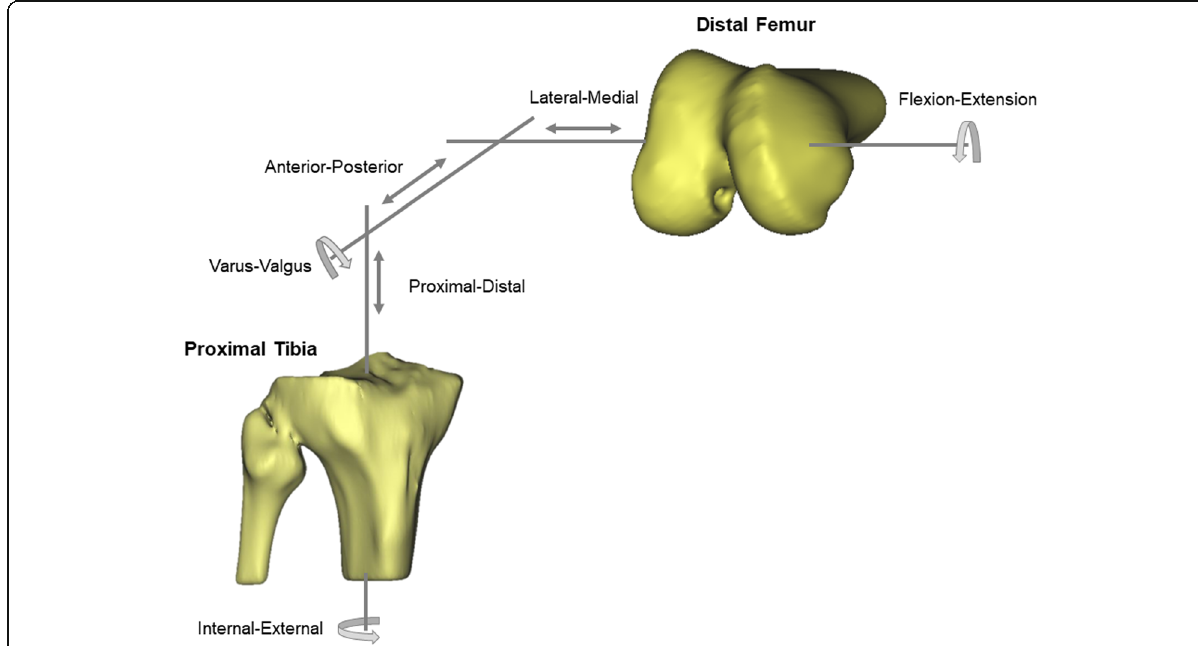
Fig. 1 Grood/Suntay joint coordinate system, demonstrated on a bony knee model. Medial-lateral translation and flexion-extension occurs along/ about the femoral fixed axis, positioned through both femoral epicondyles and consequently perpendicular to the sagittal plane. Proximal-distal translation and internal-external rotation occurs along/ about the axis, fixed to the tibial shaft. Anterior-posterior translation and valgus-varus rotation occurs along/about the floating axis, defined by the cross product of the femoral and tibial axes and therefore perpendicular to both body fixed